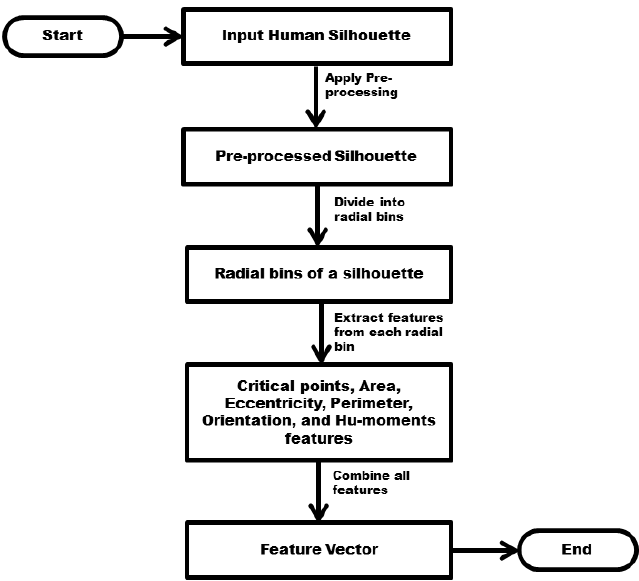
Figure 2. Overview of feature extraction process.